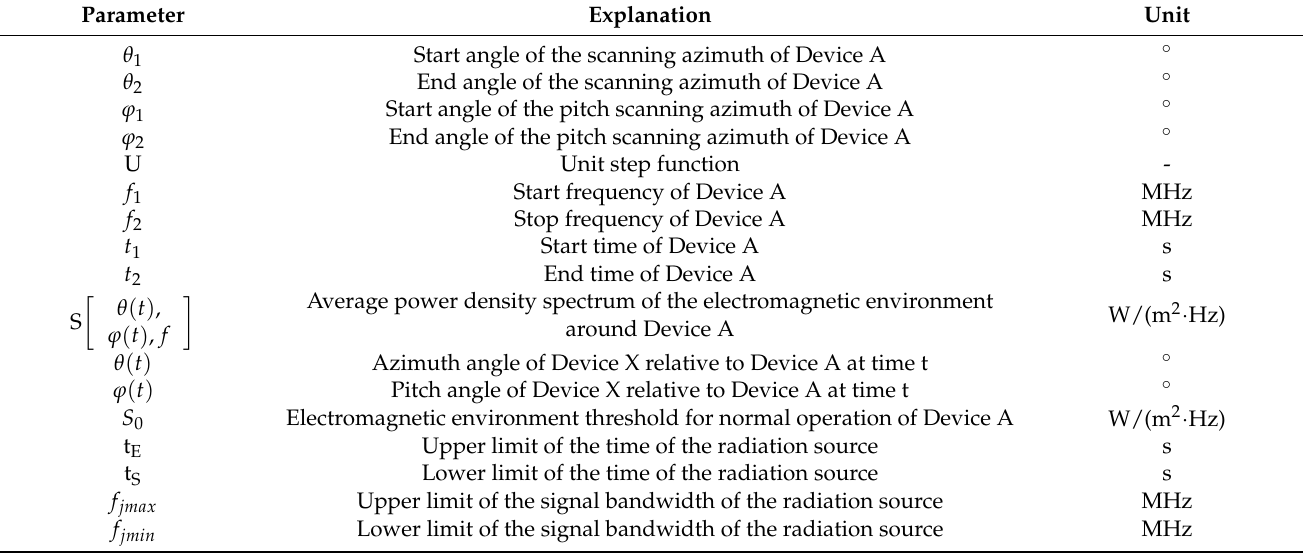
Figure 3. Electromagnetic environment modelling. ( a ) Electromagnetic interference calculation level; ( b ) Electromagnetic environment description index. Table 1. Meaning of